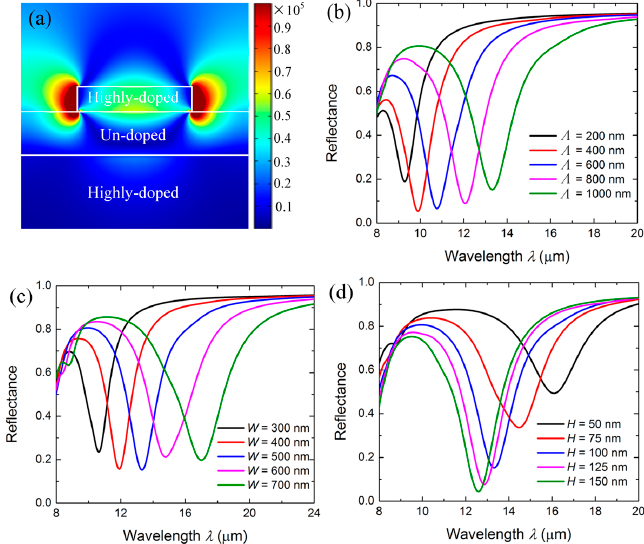
Figure 3. ( a ) Electric intensity profile of the resonator. ( b ) Simulated reflection spectra with various periods of the patterned top layer. ( c ) Simulated reflection spectra with various widths of the patterned top layer. ( d ) Simulated reflection spectra with various heights of the patterned top layer.